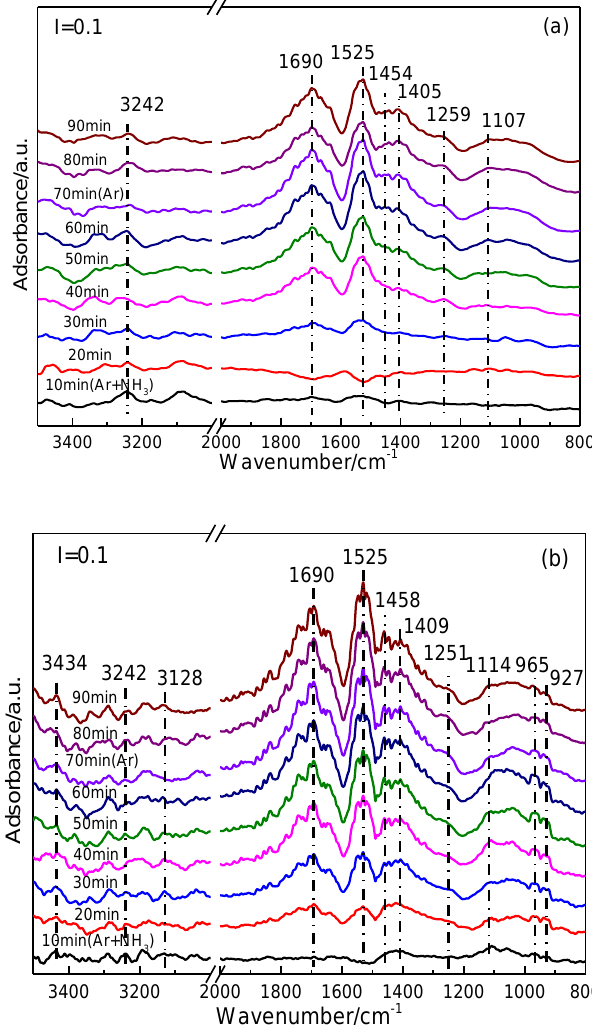
Figure 4. DRIFT spectra of SOC ( a ) and SSOC ( b ) exposed to 1000 ppm NH 3 at 300 ◦ C at di ff erent time.